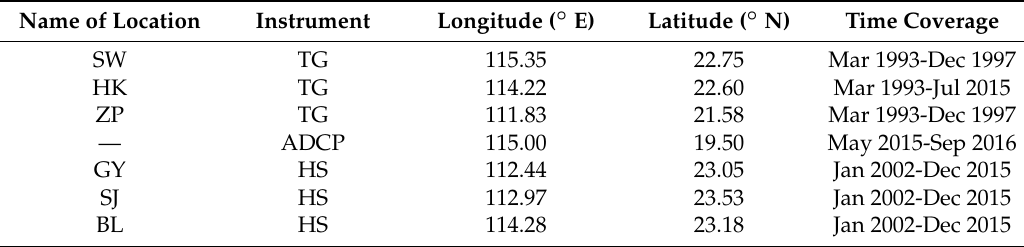
Table 1. Data information in this